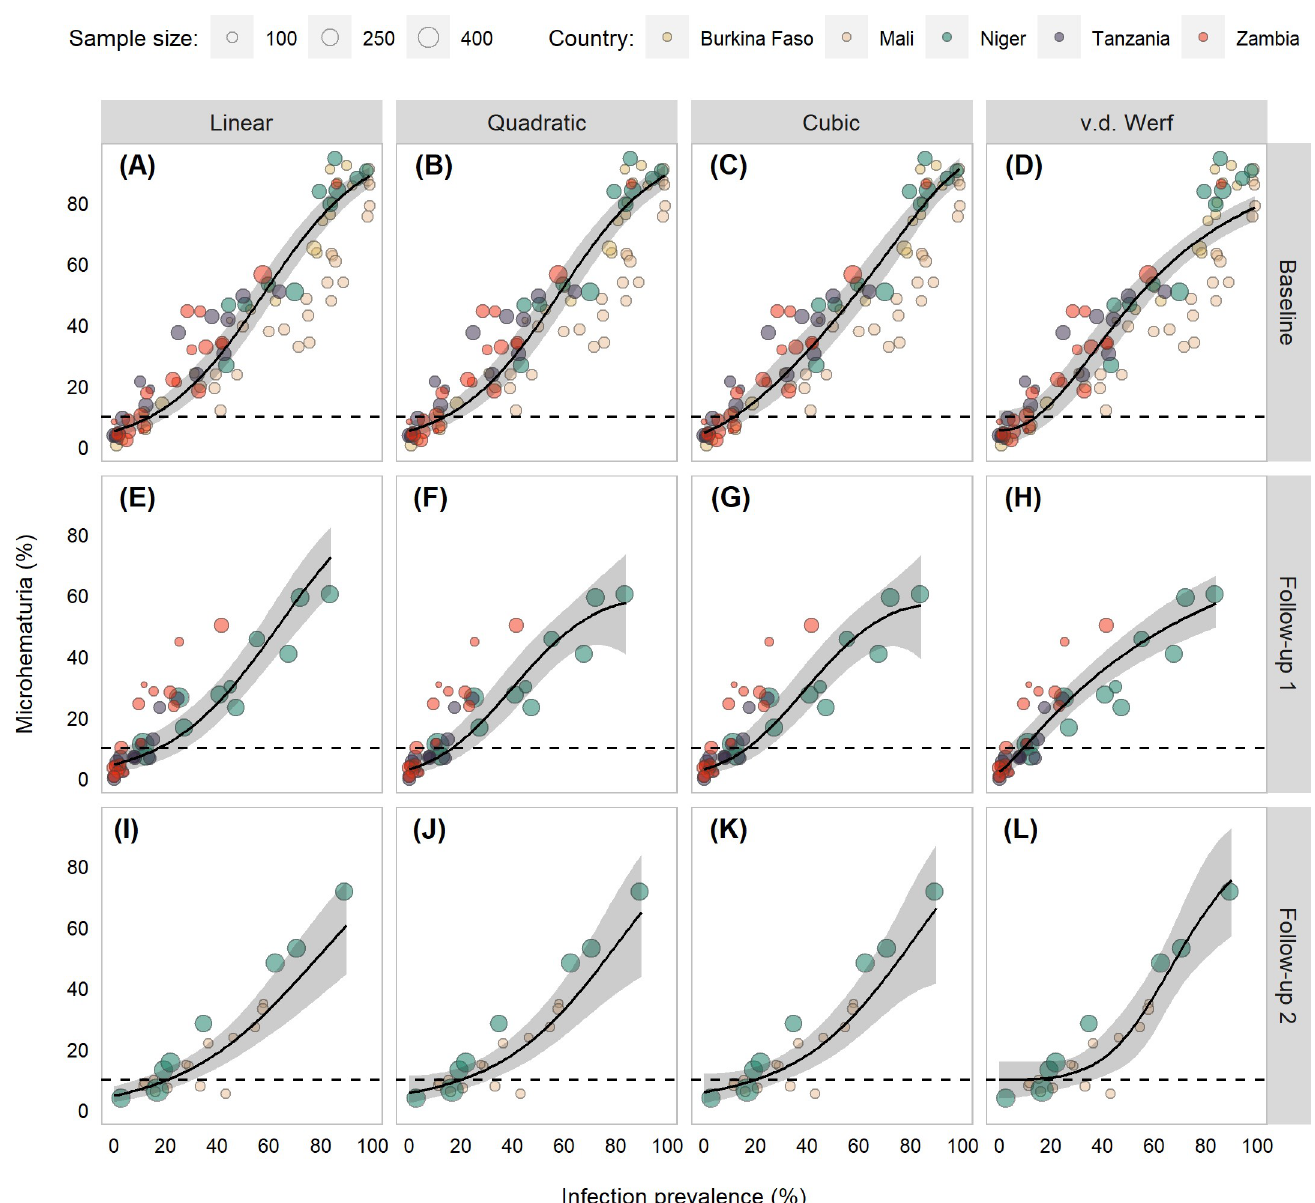
Fig 1. Scatter plots of Schistosoma haematobium infection prevalence and microhematuria prevalence of children aged 6–15 years from Burkina Faso, Mali, Niger, Tanzania, and Zambia participating in schistosomiasis control program activities between 2003 and 2008. Points are scaled based on the number of school-age children with S . haematobium infection data. Black line indicates model fits and gray shading indicates 95% Bayesian credible intervals (BCIs) from errors in variables model. The dashed line denotes 10% microhematuria prevalence.